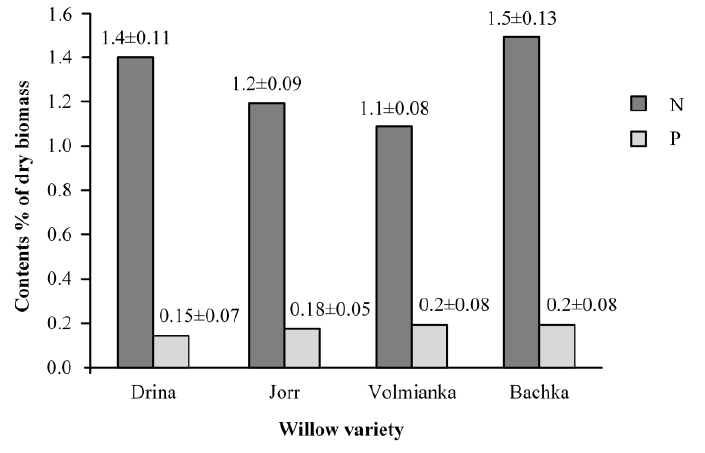
Fig. 3. The content of nitrogen and phosphorus in willow wood, X̅ ± S x , November